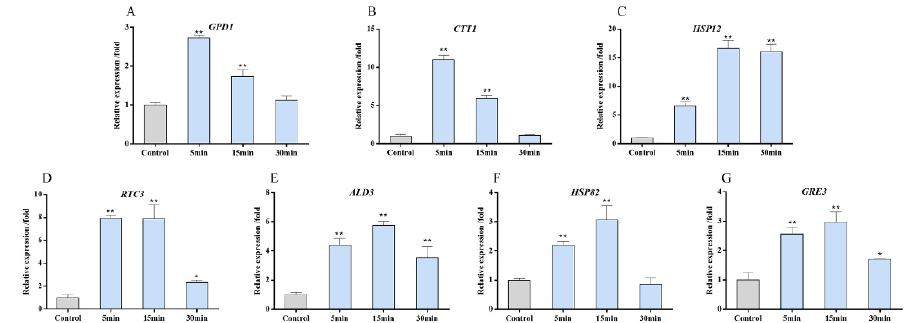
Figure 5. The subcellular localization of Hog1 activated by copper. ( A ) Laser scanning confocal microscopy showing GFP-tagged Hog1 in WT cells after treatment with CuSO 4 (4 mM for 5 min). ( B ) Quantification of Hog1-GFP nuclear localization, as in ( A ). Cells were visualized under a Nikon A1 HD25 confocal microscope. ** p < 0.01.